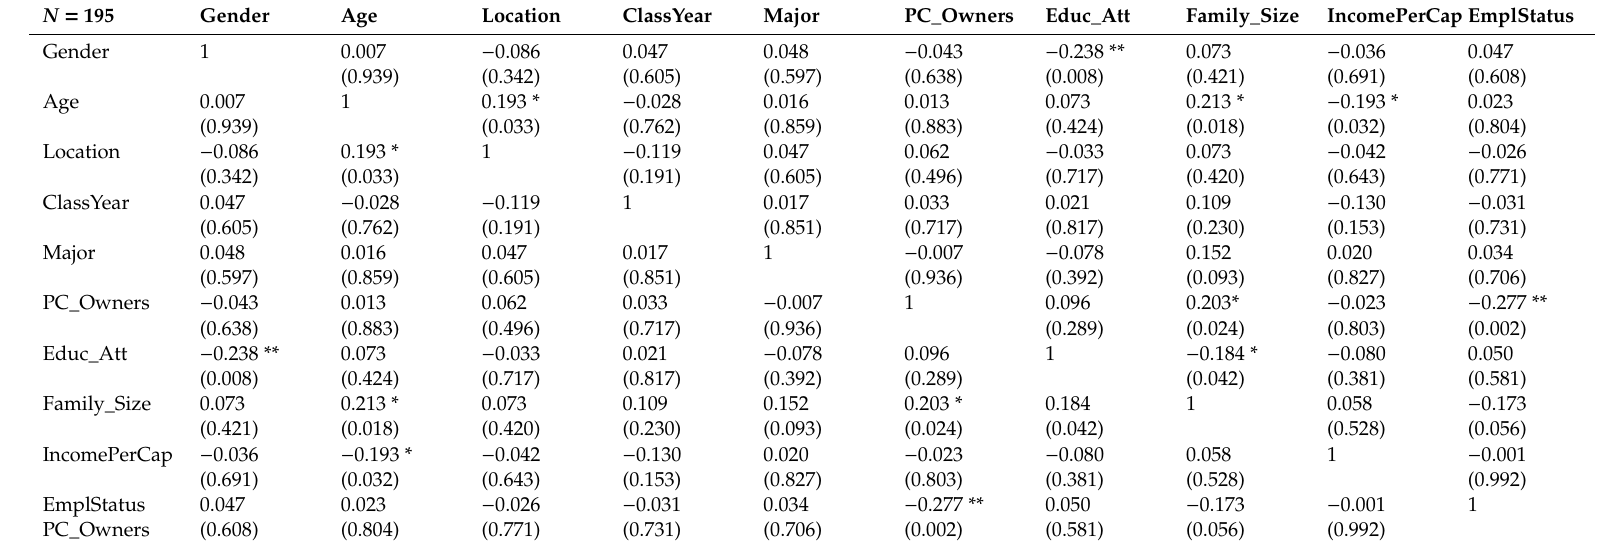
Table 5. Correlation between variables characteristics of Matrix M and W for the 3rd